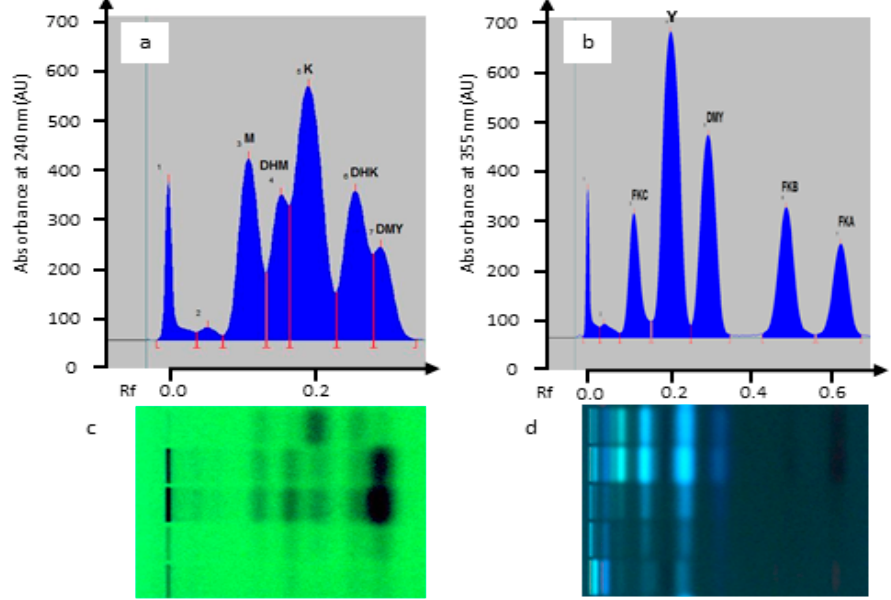
Figure 2. ( a ) Scan at 240 nm allowing the detection and quantification of methysticin (M), dihydromethysticin (DHM), kavain (K) and dihydrokavain (DHK). ( b ) Scan of the same plate at 355 nm, allowing detection and quantification of flavokavin C (FKC), yangonin (Y), desmethoxyyangonin (DMY), flavokavin B (FKB) and flavokavin A (FKA). Under each HPTLC chromatogram are photos taken at 254 nm ( c ) and 366 nm ( d ) of the corresponding plates. Table 2. Quantification of six major kavalactones and three flavokavins (in mg / g *) in 174 varieties of root samples from Vanuatu (nobles, two-day, wichmannii).